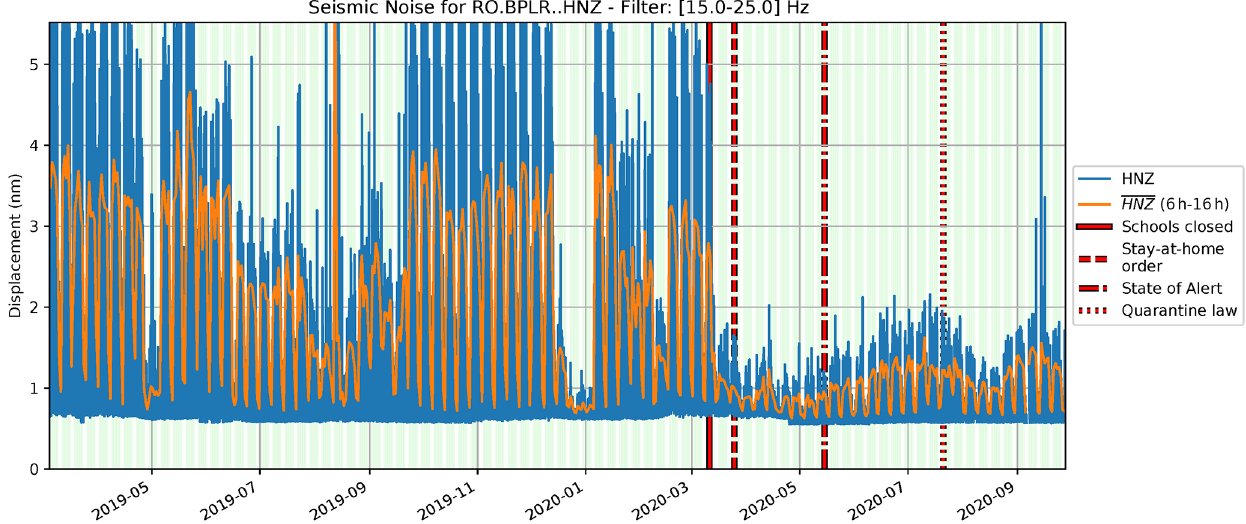
Figure 5. Lockdown effects on the seismic noise at station BPLR in Bucharest. The large drop in seismic noise of up to 66% is observed right after the school closure on 11 March 2020 (see Fig. 1 for the station locations).